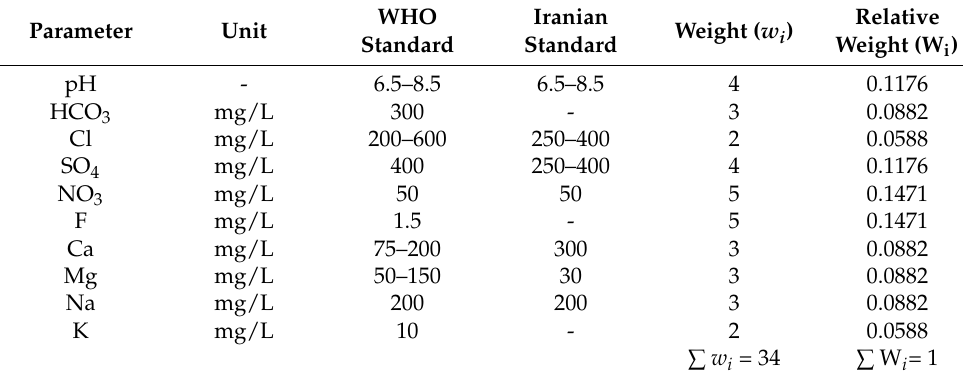
Table 1. The weight ( w i ), relative weight (W i ), and the standard value of each parameter for both Iranian and WHO standards applied in WQI calculation.